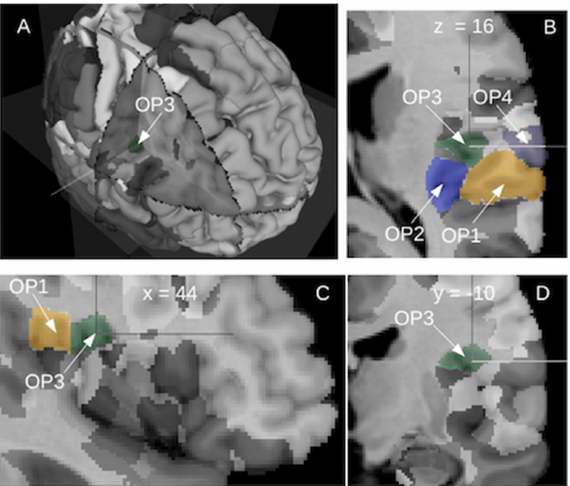
Figure 2. The posterior operculum of the right hemisphere shows four cytoarchitectonic subregions as defined by the Jülich group: lateral posterior OP1 (camel color), lateral anterior OP4 (grey), medial posterior OP2 (blue) and medial anterior OP3 (dark green). Different views: ( A ) 3D, ( B ) horizontal view, ( C ) sagittal view and ( D ) coronal view. Image derived from (https://interactive-viewer.apps. hbp.eu/, in 1 September